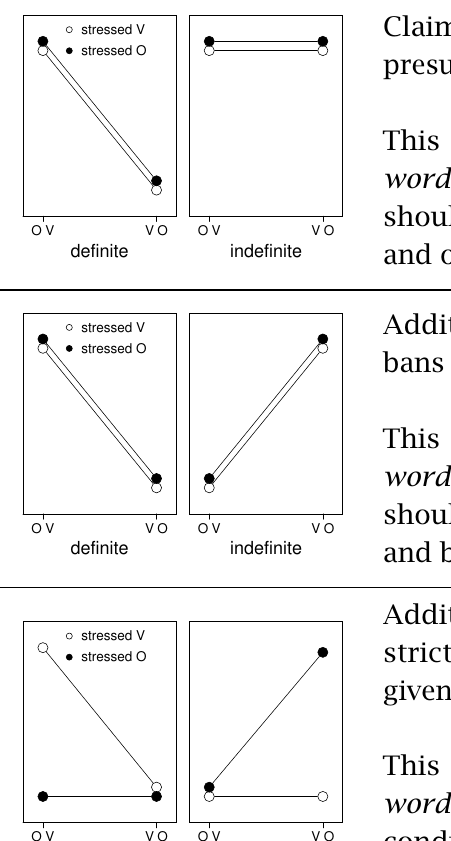
Predictions derived from the components of the system developed in Kuˇcerová 2007 ,